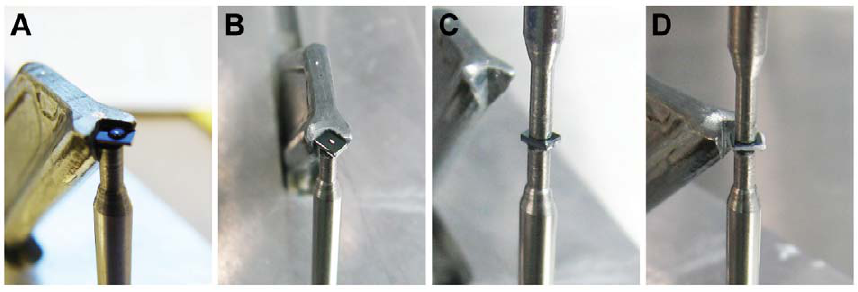
Figure 3. Pictures showing assembly of the liquid enclosure. These pictures were made of a test device without a biological sample. (A) The bottom window with a droplet of liquid is positioned on the pole of the loading device with the silicon nitride side facing up. A retractable aligner of the loading device supports two edges. (B) The top window containing the biological specimen is placed facedown on the bottom microchip. (C) A pole with a weight presses on the stack of windows. (D) The vacuum epoxy (white), serving to glue both microchips together and to vacuum-seal the micro-chamber, is visible at the sides of the micro device.